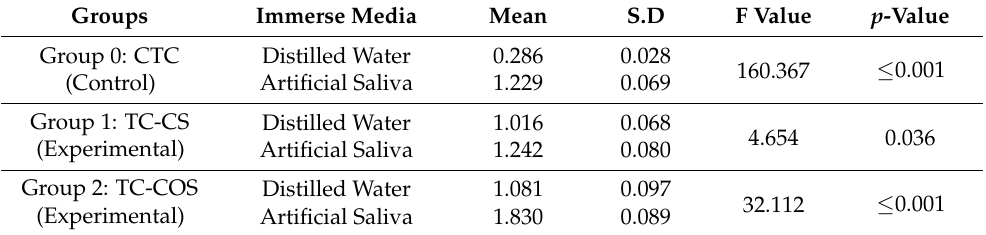
Table 3. Effect of storage media on the solubility of tested material.